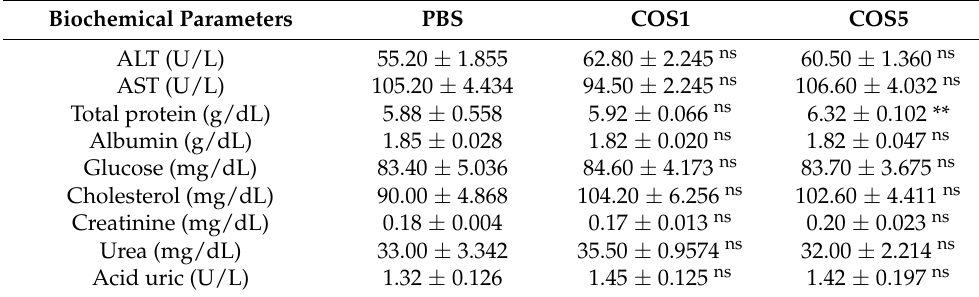
Table 2. Biochemical parameters of mice treated by intragastric route with COS1 and COS5 in acute an toxicity model.